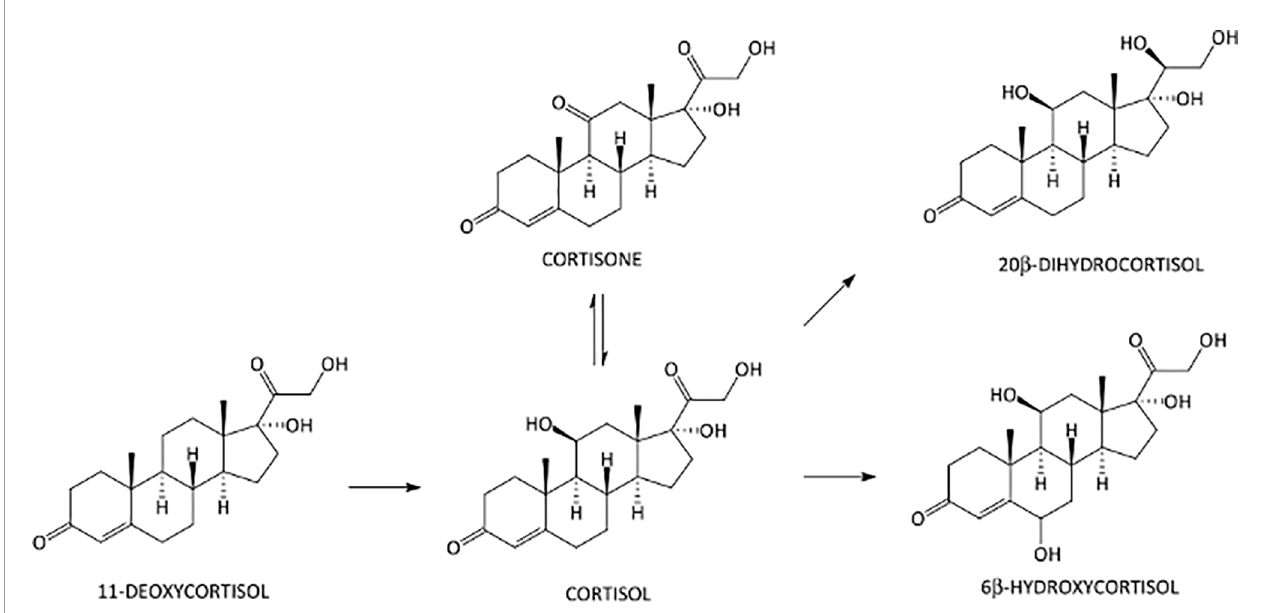
FIGURE 1 | Chemical structures of the steroids that were measured in the